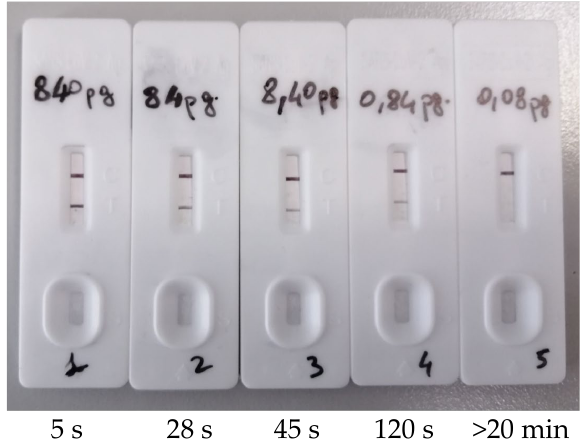
Figure 4. Assessment of limit of detection for the Ag-RDT. Serial dilutions of recombinant SARS-CoV-2 Nucleocapsid (N) protein have been used to assess the lowest concentration detectable in the antigenic test. The time of appearance of the colored band in the window of the test line is also reported. Results on the cassettes have been read within 20 min.